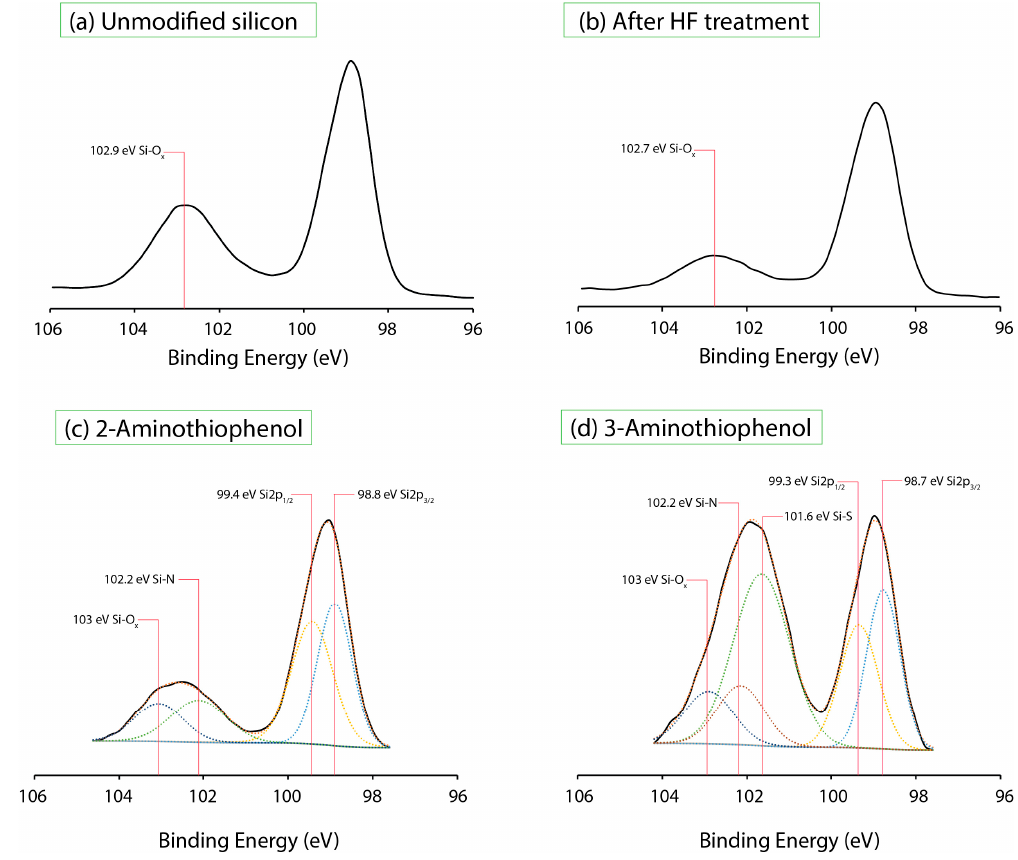
Figure 2. High resolution XPS Si2p spectra for ( a ) unmodified silicon (111), ( b ) after 5% hydrofluoric acid (HF) treatment for 30 s, ( c ) and ( d ) 2-aminothiophenol and 3-aminothiophenol after thermal grafting at 130 ◦ C for 18 h on silicon (111) hydride